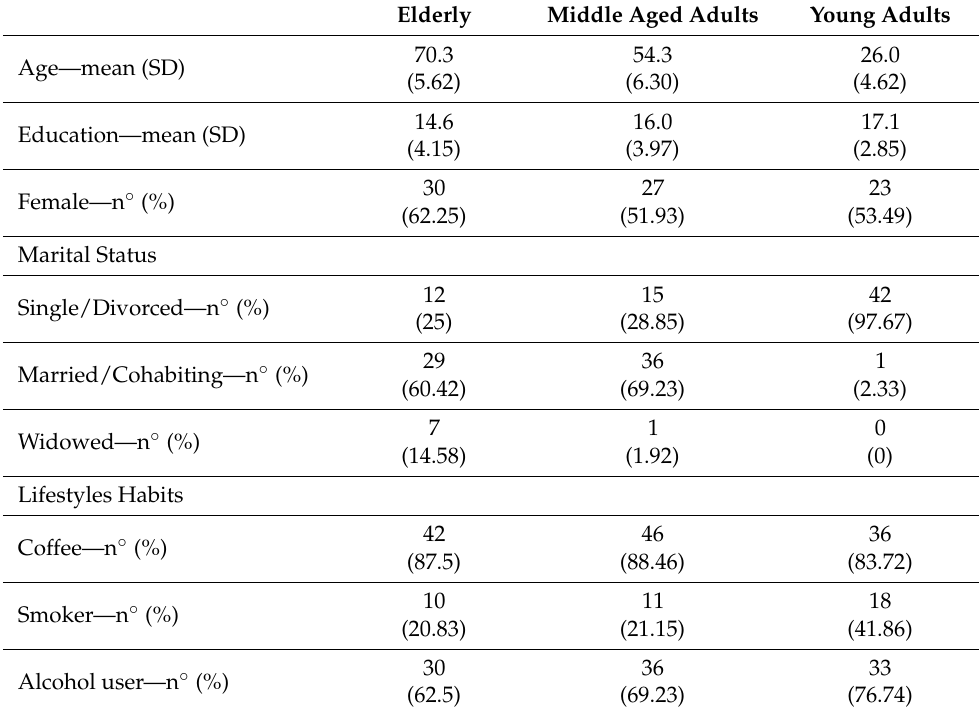
Table 1. Characteristics of